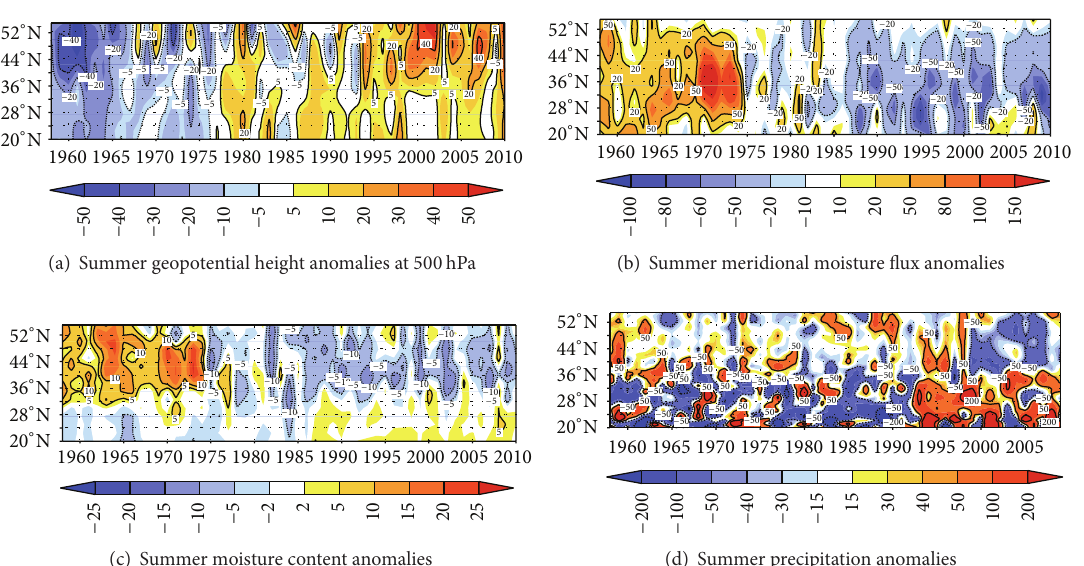
Figure 7: Time-latitude anomalies cross section (averaged over 105–120 ∘ E) of (a) geopotential height at 500 hPa, (b) meridional moisture flux, (c) moisture content, and (d) precipitation in summer.